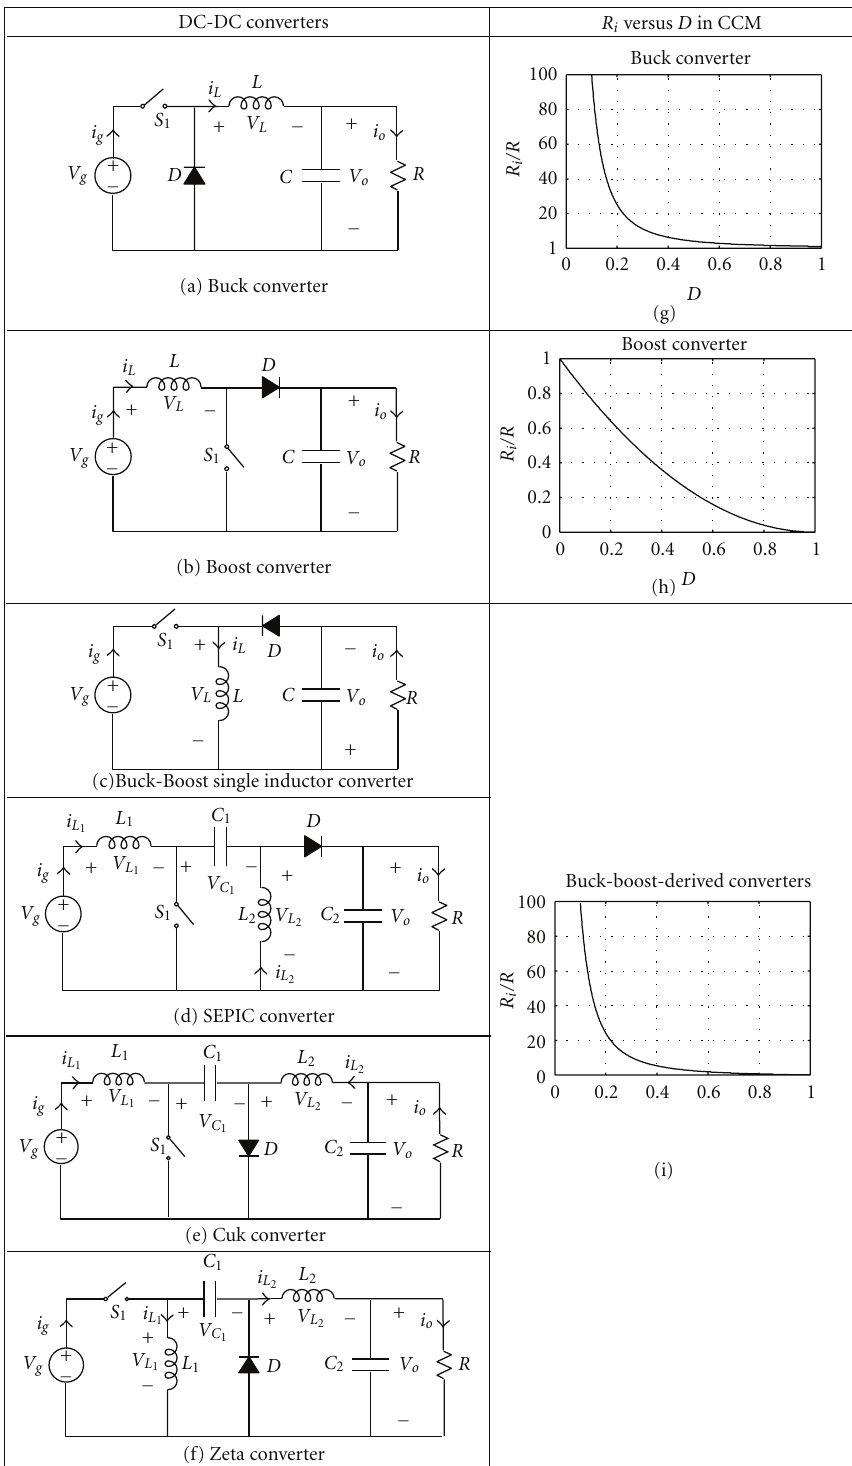
Figure 2: Di ff erent topologies of converters and representation of input resistance versus duty cycle for CCM. CCM, while small ones lead to DCM. The critical value of K The previous analyses of the Buck, Boost, and Buck- at the boundary between modes ( K crit . ) is a function of the Boost-derived converters are summarized in Table 1. The dimensionless parameter K is a measure of the tendency of duty cycle. If K is over the unit, then the converter operates in CCM for all duty a converter to operate in DCM. Large values of K lead to